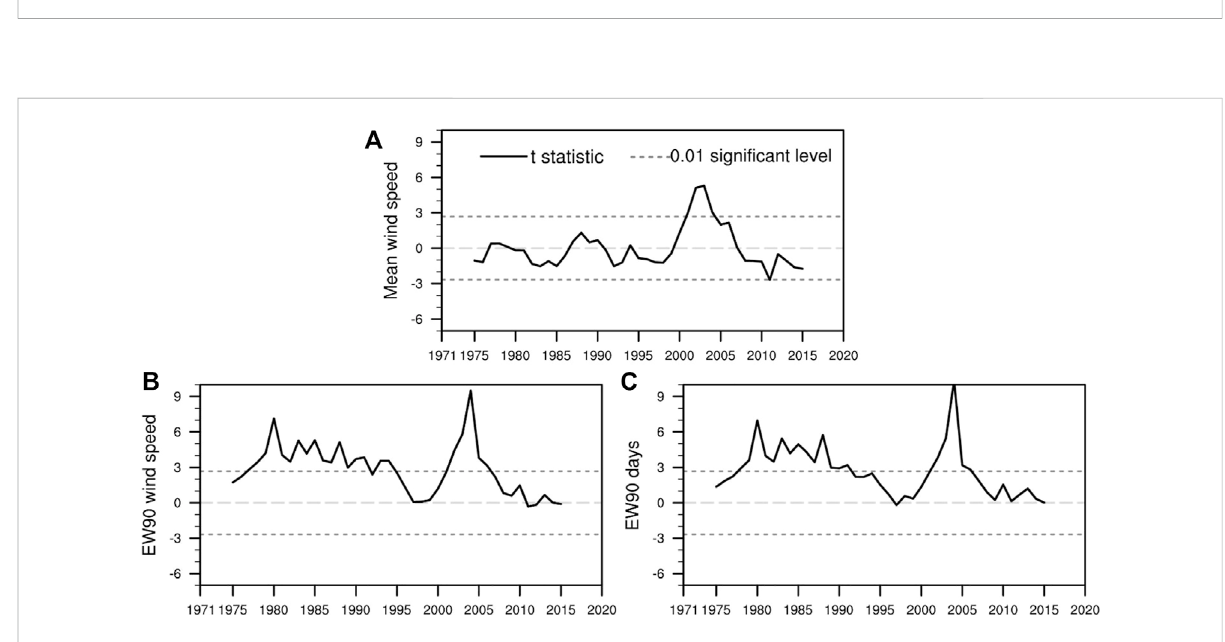
FIGURE 8 Mean windspeed (a1 – c1, m s − 1 )and annual totaloccurring days (a2 – c2, d)ofEW90,EW95andEW99 windextremes,and annualmean valueof daily mean wind speed (d1, m s − 1 ) and sandstorm days (d2, d). Their variation trends (linear regression coef fi cients) are also marked in the fi gure, and the regression coef fi cients passing the 99% signi fi cance test are shown in bold.